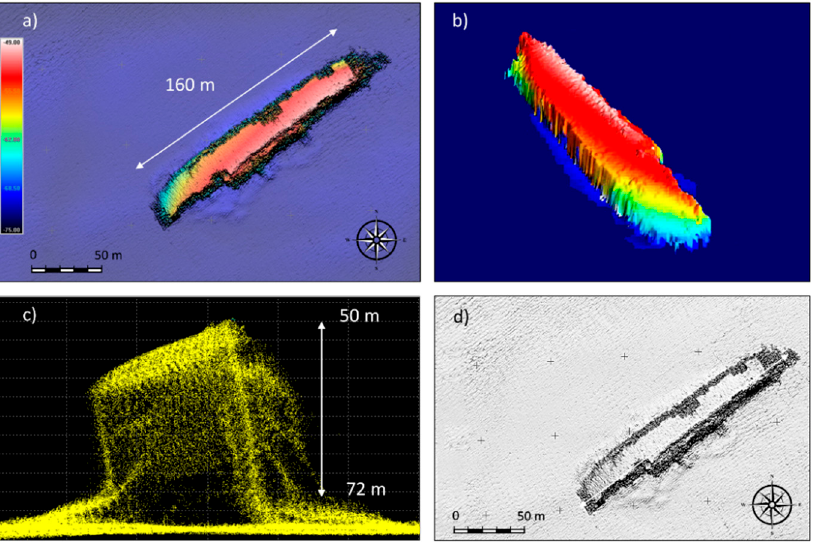
Figure 6. Different types of multibeam data presentation. ( a ) sun-illuminated grid data, ( b ) digital terrain model, ( c ) profile view data, and ( d ) multibeam backscatter grid data.